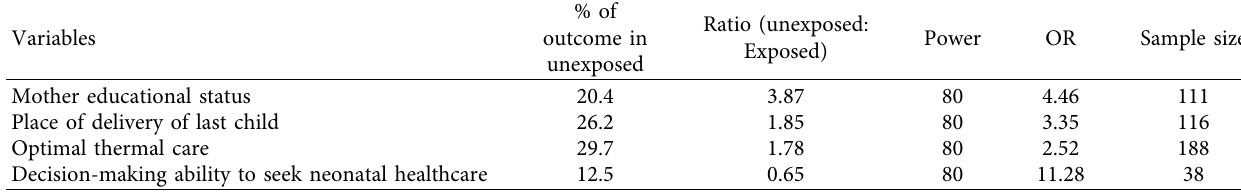
Table 1: Te second objective the required sample size was calculated by using Epi-Info software version 7.0, to identify independent variable and compare for the largest sample